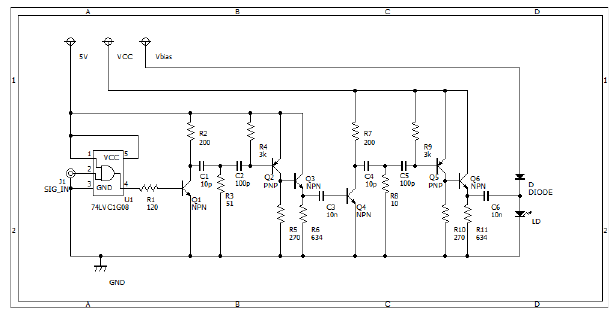
Fig. 3. A schematic diagram of the waveform shaping circuit in the pulsed laser. An external trigger signal is received by the connector indicated as “SIG_IN”. The trigger signal is to be reshaped to a short pulse, which is applied to a LD. The height of the short electric pulse is variable by adjusting the input voltage indicated as Vcc.